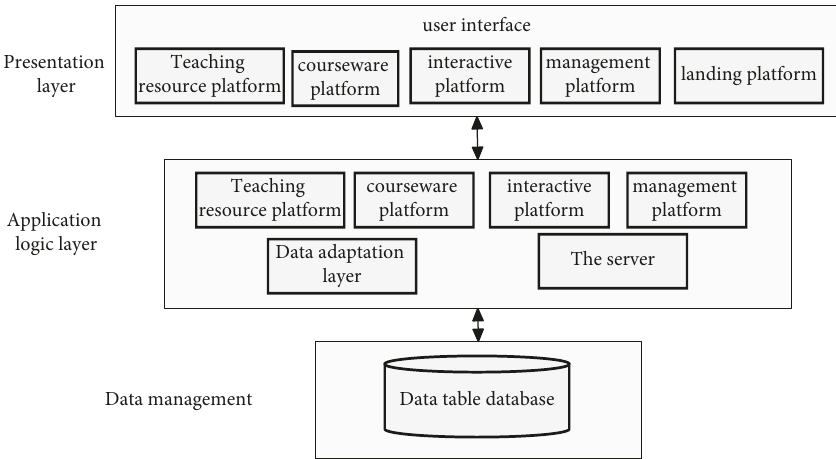
Figure 4: System structure of university sports network education resource sharing